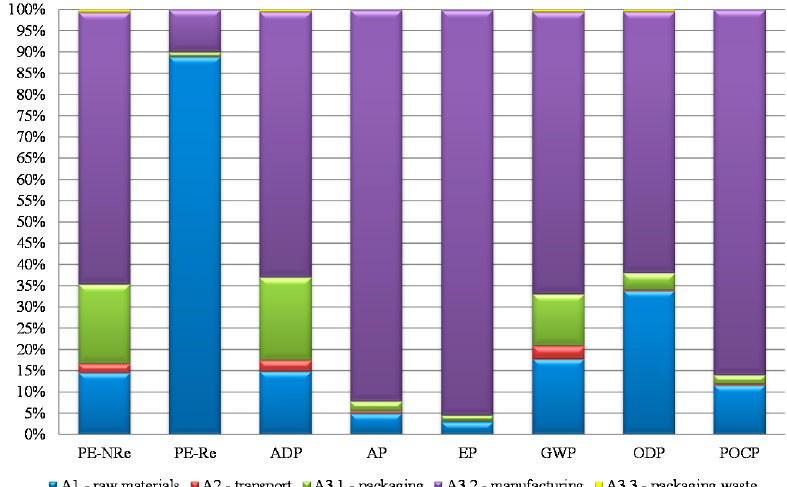
Figure 4. Relative contribution of each sub-stage of ICB production to environmental impacts [5]. PE-NRe: Consumption of non-renewable primary energy; PE-Re: Consumption of renewable primary energy; ADP: Depletion of abiotic resources; AP: Acidification potential of soil and water; EP: Eutrophication potential; GWP: Global warming potential over a 100-year span; ODP: Ozone depletion; POCP: Photochemical ozone creation potential.